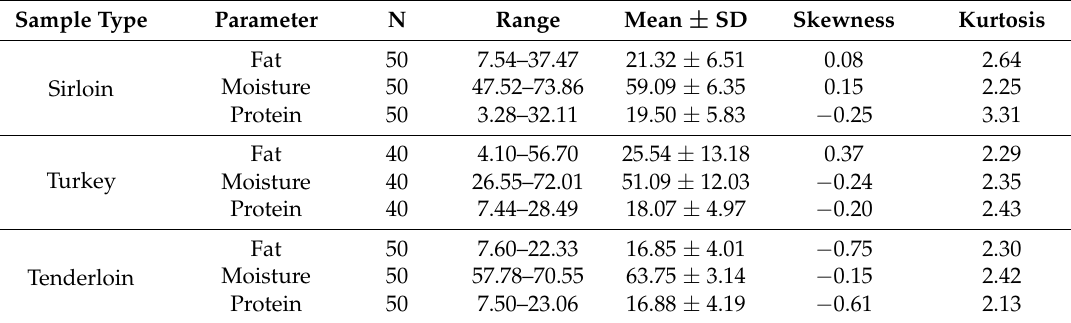
Table 1. Descriptive statistics of measured